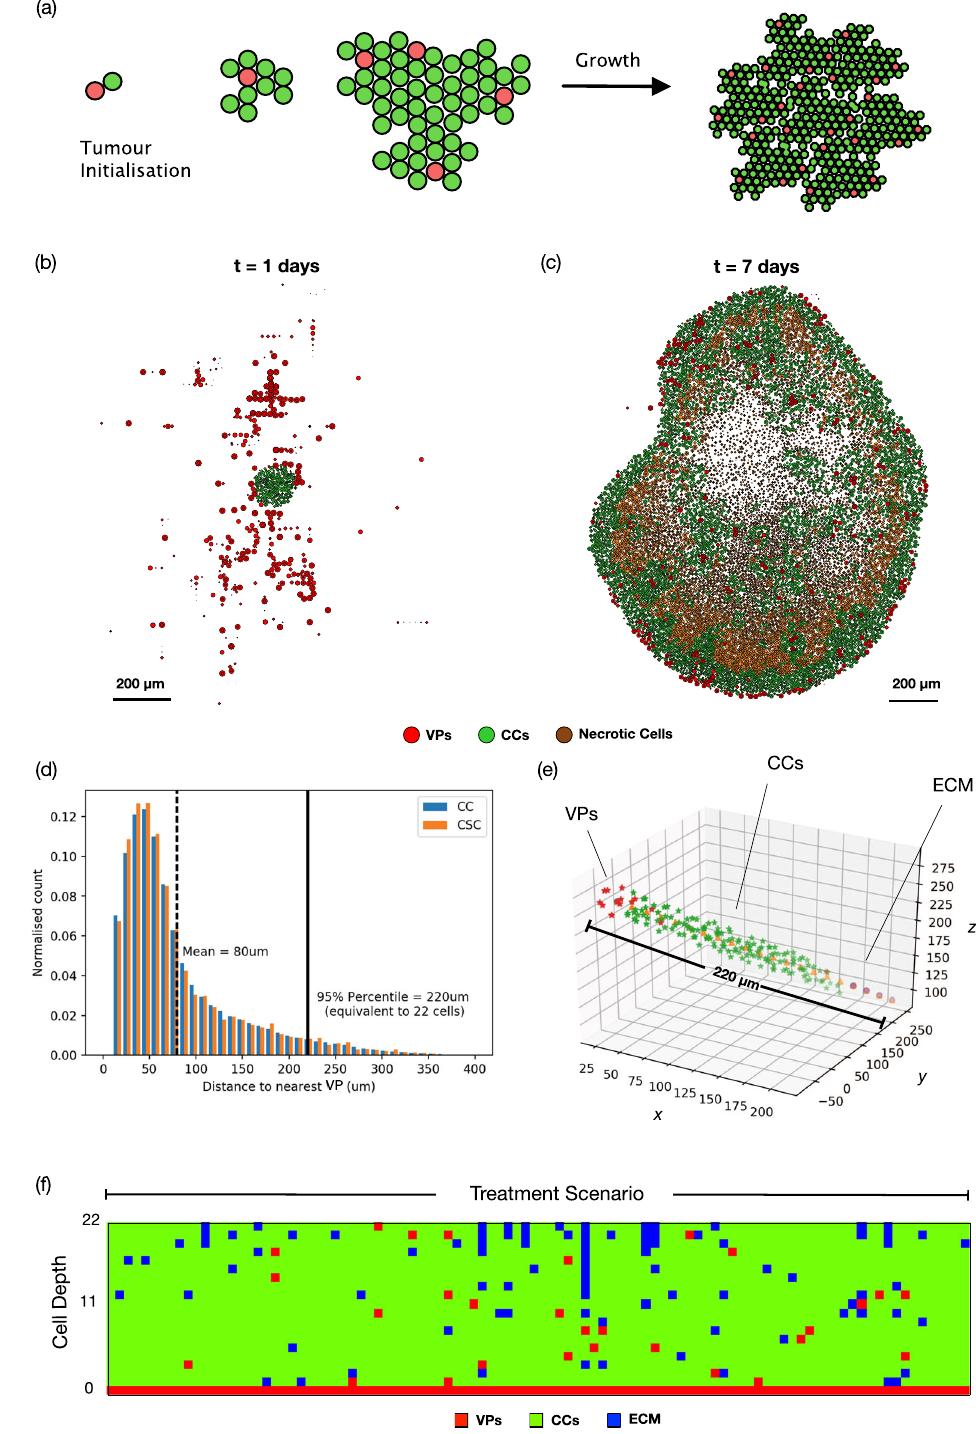
Fig. 2 Virtual tumour module of the EVONANO platform. Tumours are grown in silico by ( a ) initialising tumour with several cells (shown as green circles) and vessel points (shown as red circles) and running simulation until the tumour population is suf fi ciently large. All simulations are performed using PhysiCell, where ( b ), ( c ) show example outputs of a tumour with VPs and oxygen gradients where VPs are represented by red circles, green circles are CCs and brown circles are CC undergoing necrosis due to oxygen depletion. We use simulation output to ( d ) calculate the distance required for nanoparticles to penetrate from VPs and cover 95% of the tumour as well as ( e ) construct treatment scenarios such as those shown in ( f ), where red squares represent VPs, green squares represent CCs and blue squares represent